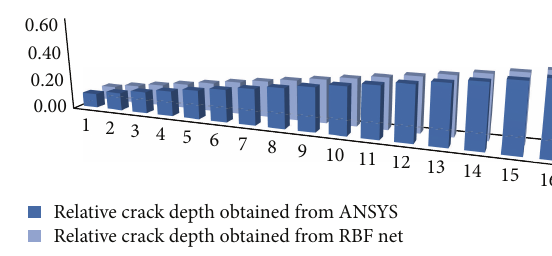
Figure 13: Comparison of result of relative crack depth between ANSYS and FFBP network.